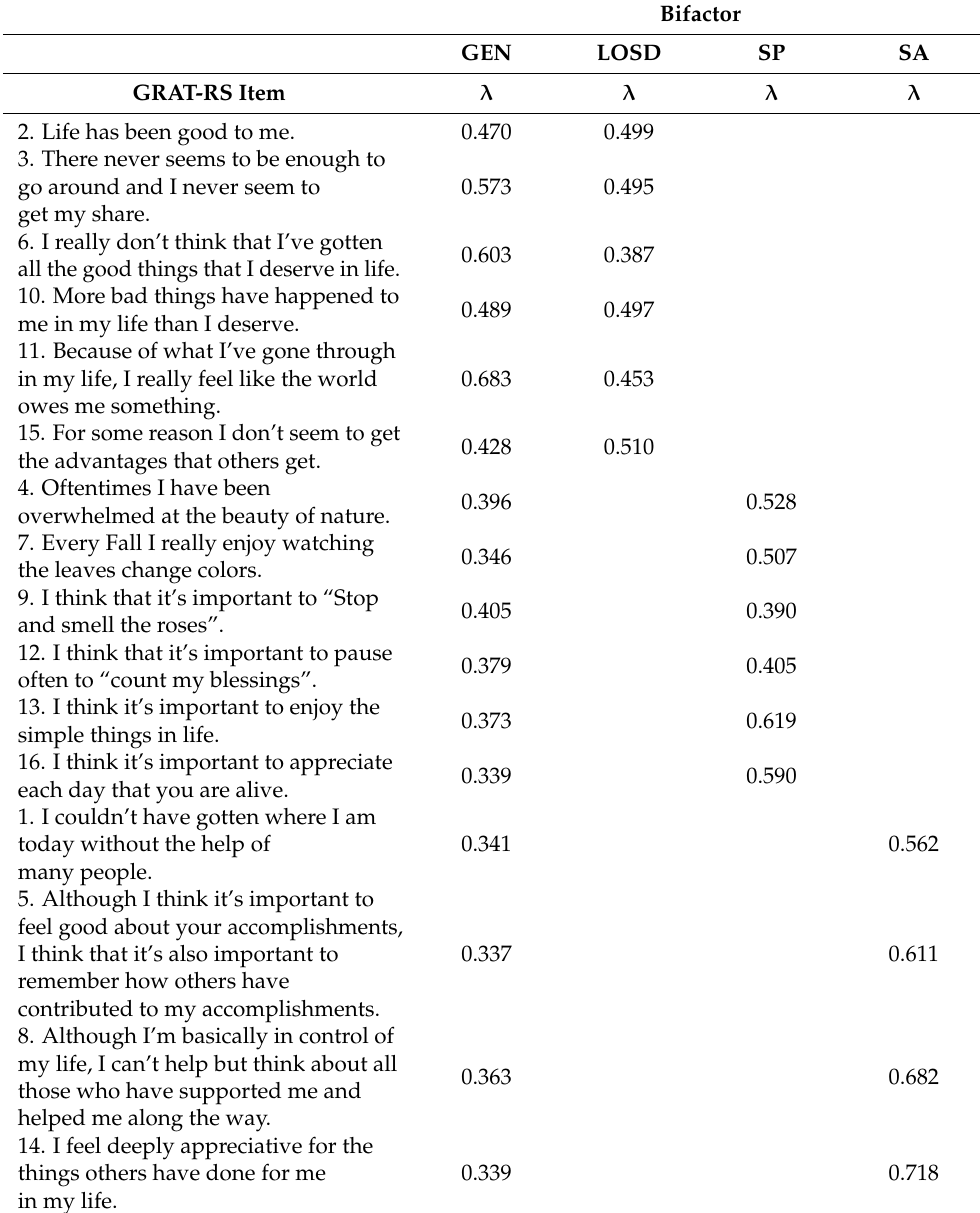
Table 3. The Gratitude Resentment and Appreciation Test-Revised Short (GRAT-RS): multidimen- sional item response theory (MIRT) analyses. Factor loadings of ( n =